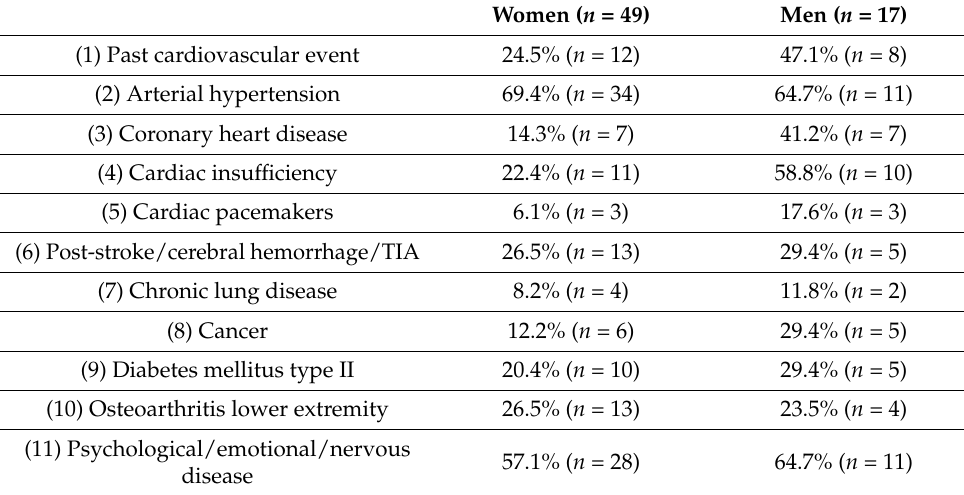
Table 4. Categorized comorbidities of the BaSAlt cohort.